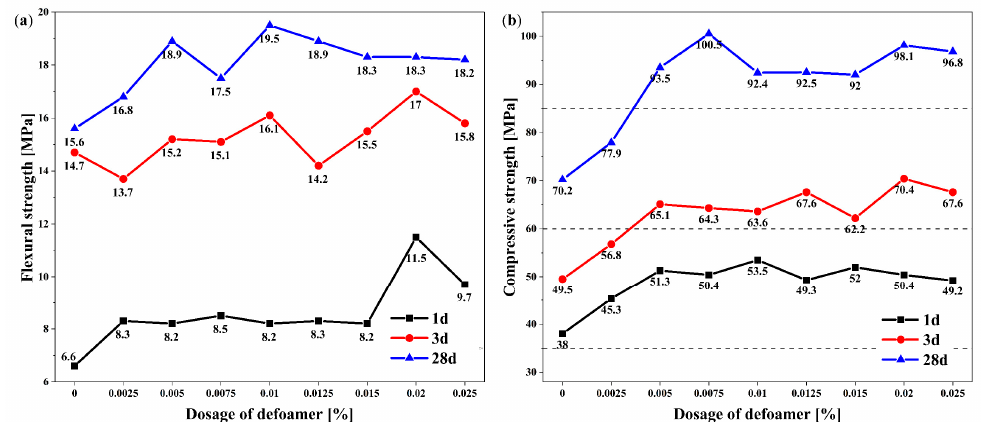
Figure 3. Influence of defoamer on the mechanical properties of grouts: ( a ) flexural strength; ( b ) compressive strength.